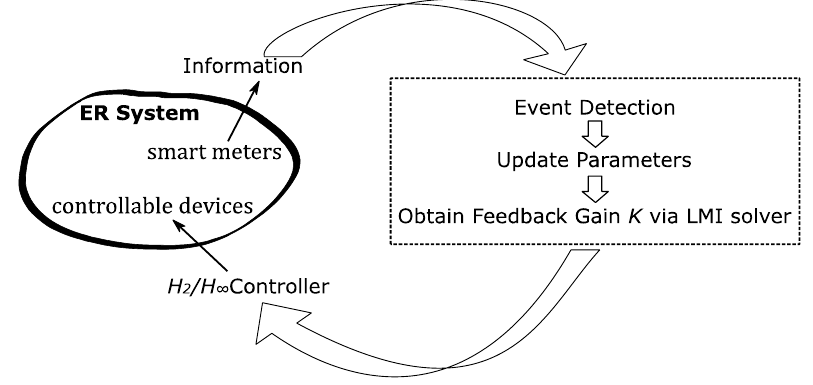
Figure 2. The detailed procedures of the proposed mixed H 2 / H ∞ control approach.